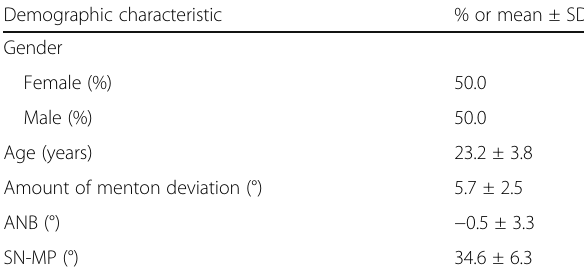
Table 3 Description of the subjects ( n = 30) Demographic